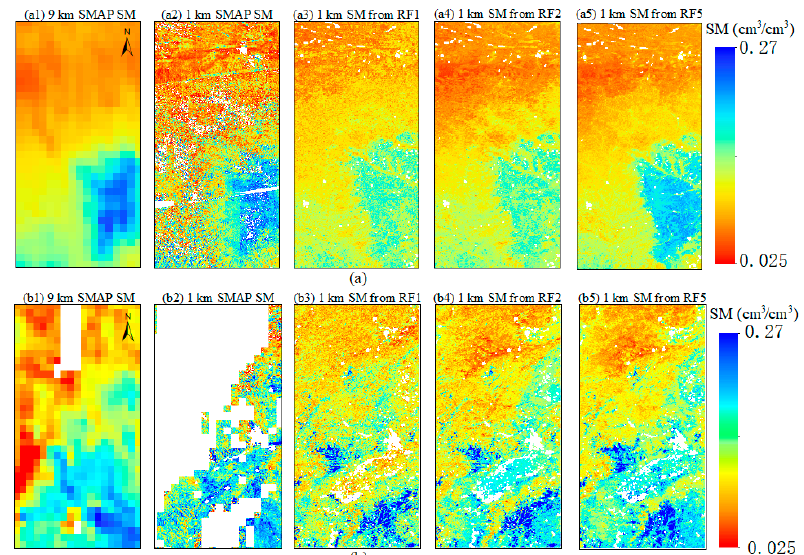
Figure 10. Spatial patterns of 9 km SMAP passive SM data (first column), 1 km L2_SM_SP optional data (second column), and 1 km downscaled SM data based on RF1 (third column), RF2 (fourth column) and RF5 (fifth column) in ( a ) region A (DOY = 2018, 71) and ( b ) region B (DOY = 2017, 342).